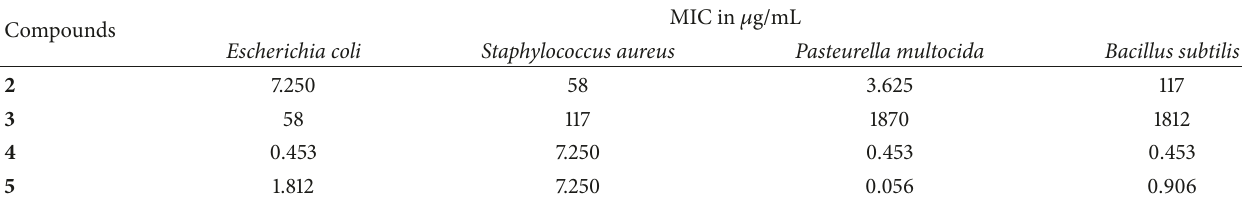
Table 2: Minimum inhibitory concentrations of synthesized compounds 2 – 5